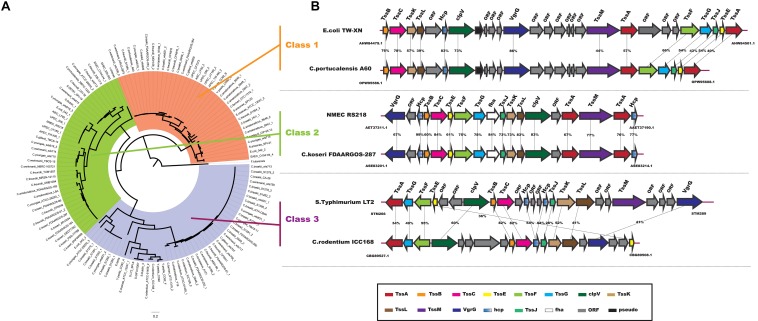
Model of T6SS in Citrobacter strains. (A) Phylogenetic tree of select T6SS gene clusters. The figure was made using the sequences of the TssF core component homologs. (B) Genes encoding the T6SS-1, T6SS-2, and T6SS-3 in the indicated Citrobacter strains are shown schematically. Homologous genes are colored similarly (see box below).